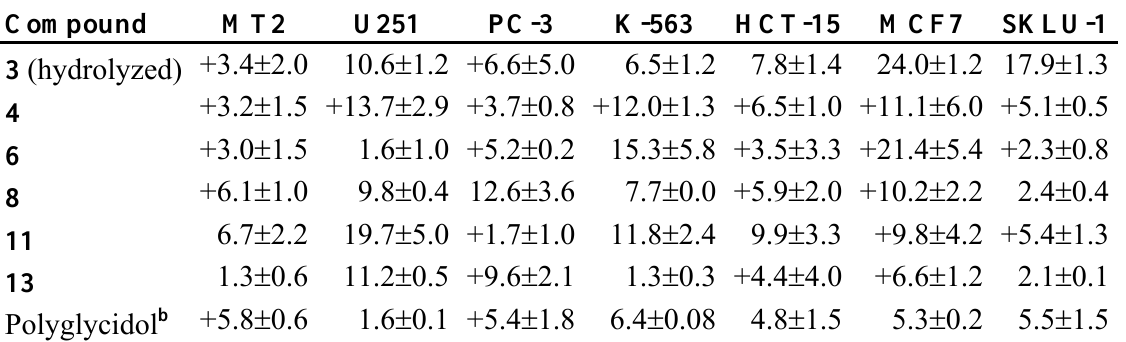
Table 1. Activity (%) of human cancer cell lines and human lymphocytic MT2 cells. a